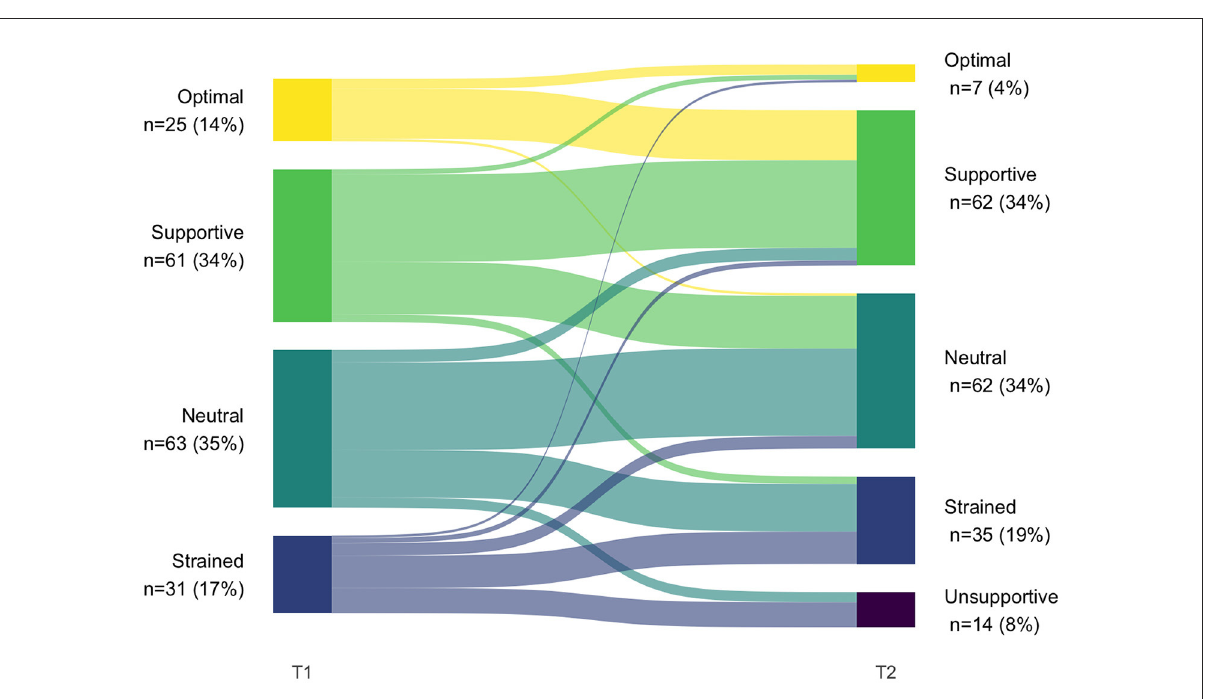
FIGURE3 Pattern of latent profile transitions from T1 to T2 ( N =